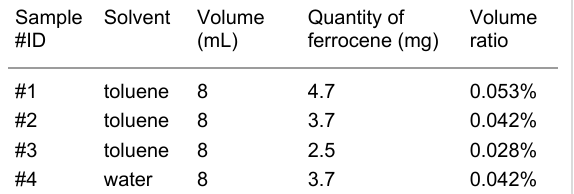
Table 1: Solvent type and amount of ferrocene used in this work.